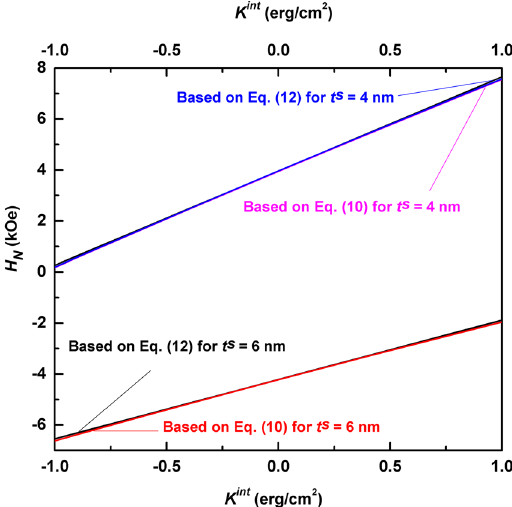
Figure 3. Comparison of the nucleation fields based on Eqs (10) and (12) for Nd 2 Fe 14 B/ α -Fe multilayers, demonstrating excellent agreement between the two formulas. The hard layer thickness is set as 12 nm in calculating the nucleation fields from Eq. (10).